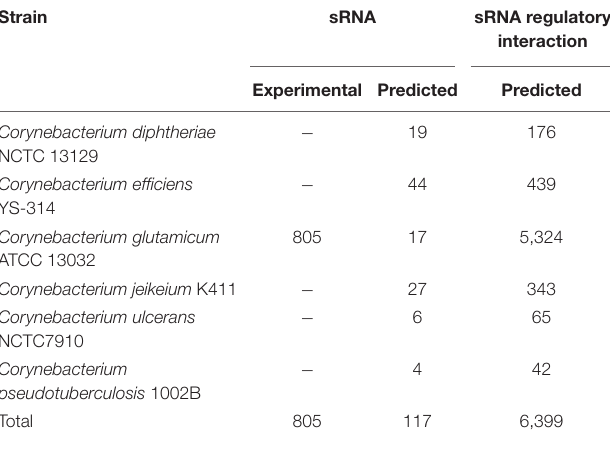
TABLE 2 | New, sRNA-related database content of CoryneRegNet